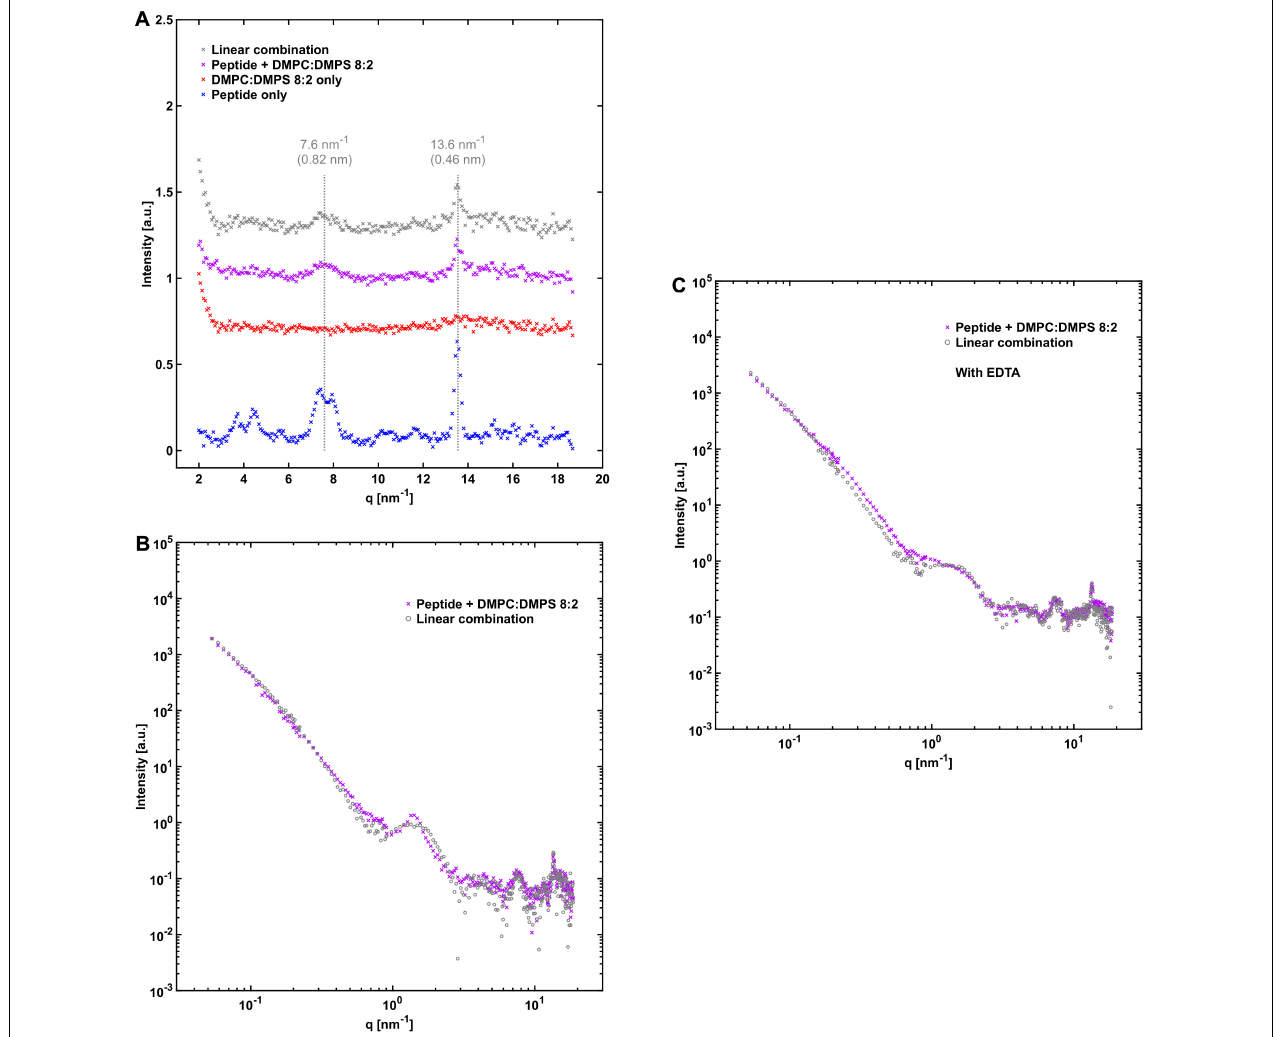
FIGURE 7 | NACore together with DMPC:DMPS. (A) WAXS profiles similar to those in Figures 4A , 5A , but with DMPC:DMPS as the lipid system. (B) SAXS profile of NACore co-incubated with DMPC:DMPS, together with a linear combination of scattering from fibrils and vesicles (0.30 fibrils + 1.20 · vesicles). A sharp peak at q = 1.4 nm − 1 is present in the scattering profile of the co-incubated sample. (C) SAXS profile of NACore co-incubated with DMPC:DMPS, together with a linear combination of scattering from fibrils and vesicles (0.70 · fibrils + 0.90 · vesicles), with 0.1 mM added EDTA. The sharp peak at q = 1.4 nm − 1 is not present. For all experiments with this lipid system incubation and measurements were done at 37 ◦ C instead of at room